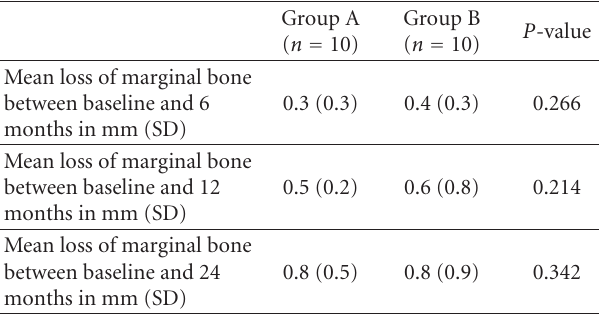
Table 4: Results from radiographic